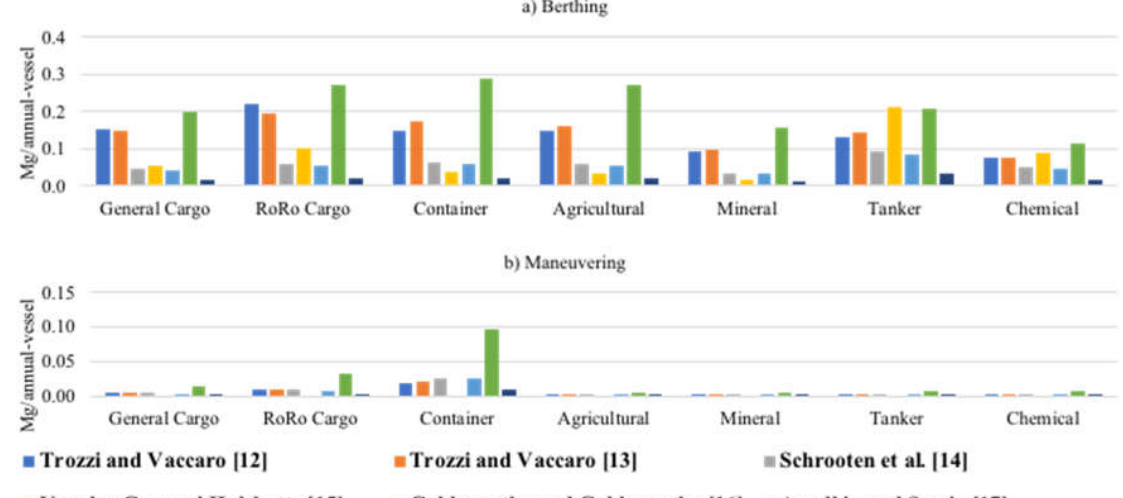
Figure 9. Distribution of atmospheric emission (Mg/annual-vessel) of SO 2 for each method in ( a ) berthing and ( b ) maneuvering position.